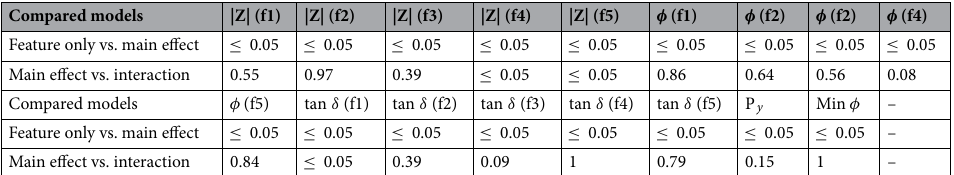
Table 1. Significance of the Linear Mixed Effect model quality improvement for each of the 17 selected features with the addition of the size and the interaction between the size and the feature. |Z| impedance magnitude, φ impedance phase, – no feature.